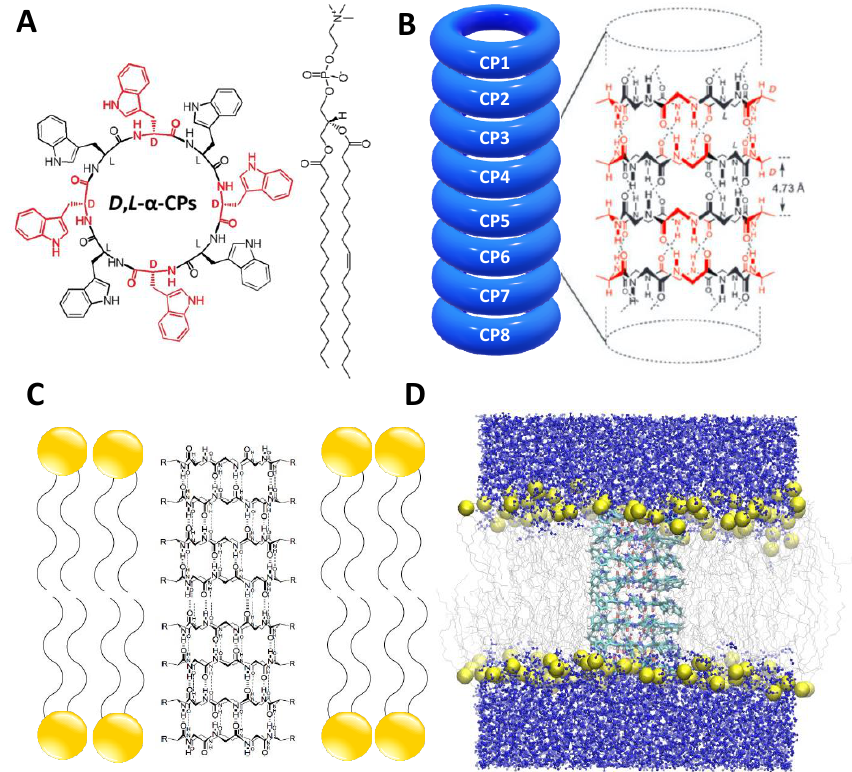
Figure 1. ( A ). Structures of the D , L - α -CP employed in this study, c -[( L -Trp- D -Trp-)4], and POPC. L - residues are represented in black and D -residues in red. ( B ). Antiparallel disposition of the CPs in the D , L -α-SCPN; note that the D (red) and L (black) residues are facing one another. ( C ). Model of the SCPN inserted into a lipid bilayer. ( D ). Initial structure used for all of the MD simulations, where the SCPN is inserted into a lipid bilayer; water molecules are on both sides of the membrane, while the nanotube cavity and the hydrophobic core of the bilayer are dry; yellow spheres correspond to the POPC phosphorous